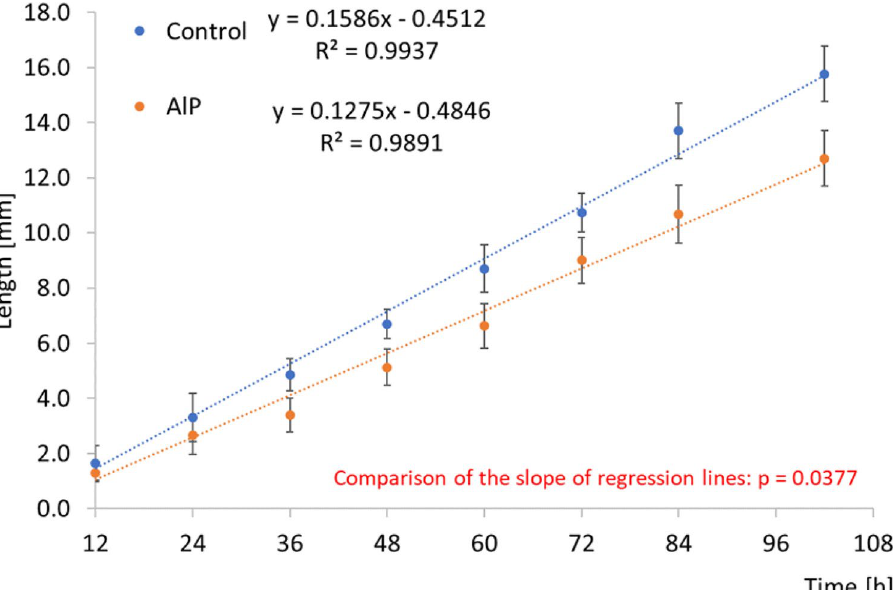
Figure 2. Length of Chrysomya albiceps larvae (mean ± SD) at different time points. Larvae were fed on AlP- treated rabbits’ carcasses (the AlP group) or sterile water (the control group) before death. Dotted lines mark regression lines. The regression line’s parallelism was tested by comparing the regression lines’ slope (GLM, equal slopes